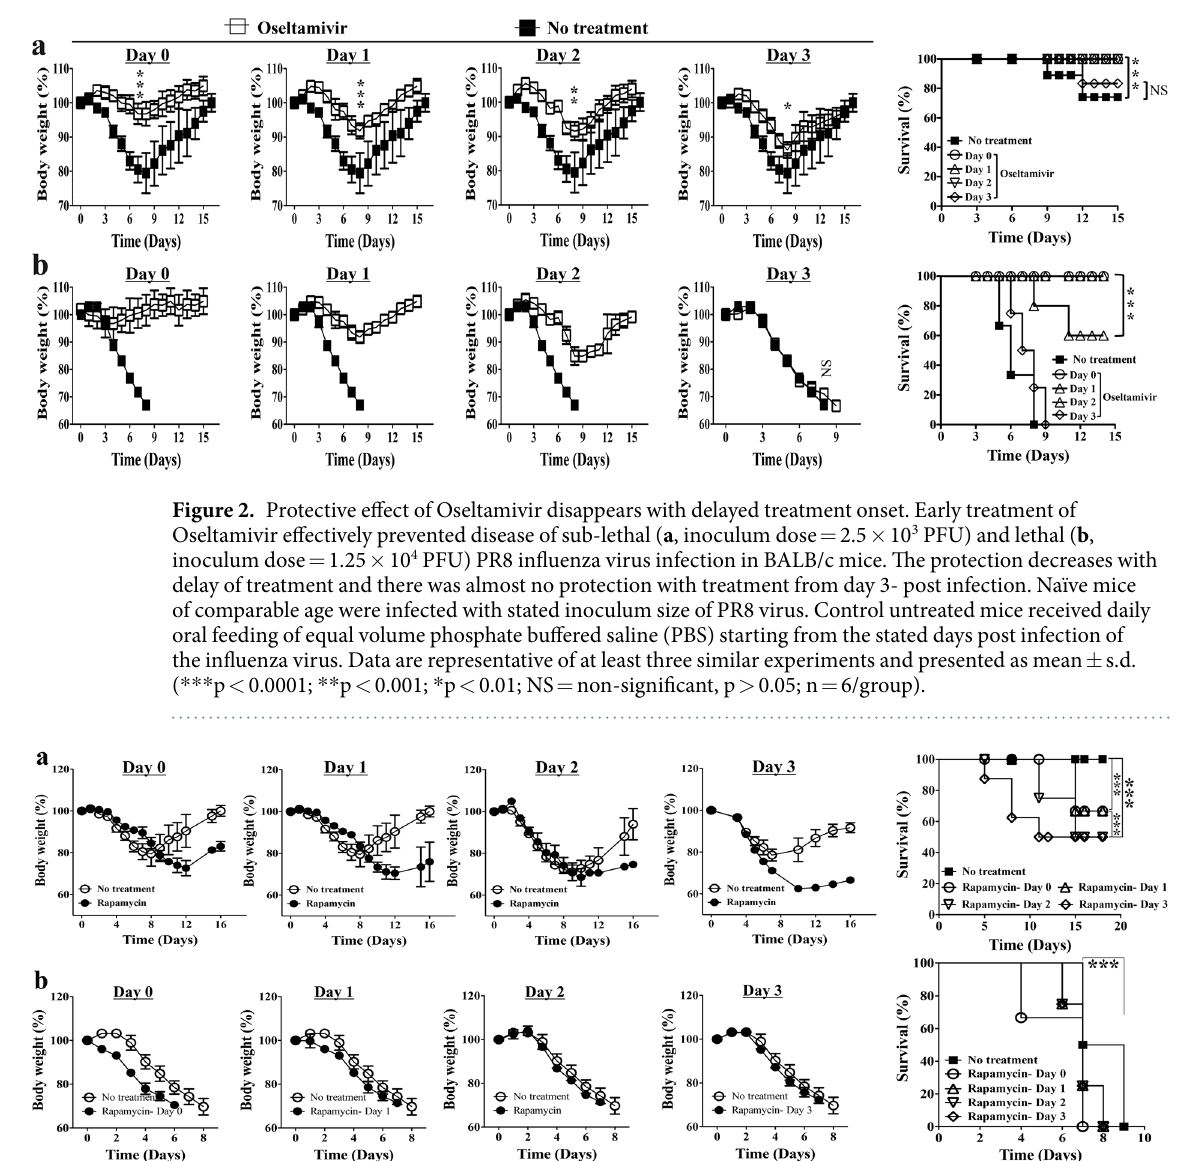
Rapamycin aggravates illness of both mild and severe disease regardless of timing of treat- ment. Rapamycin was given daily with intraperitoneal injection at the dose of 3 mg/kg of bodyweight. Immunosuppressive effects may hurt the mice in the early stage of infection during which effective immunity is desired for virus eradication. We started the timing of treatment starting from either day 0-, day 1-, day 2- or day 3- post infec- tion. Rapamycin caused more severe disease with either 2.5 × 10 3 or 1.25 × 10 4 PFU PR8 influenza virus infection, regardless of the timing of treatment. In infection with 2.5 × 10 3 PFU virus, the body weight loss was more profound in treated mice and some of them died but almost all the untreated mice recovered from illness (Fig. 3a). In infection with 1.25 × 10 4 PFU virus, both body weight loss and lethality were accelerated with Rapamycin treatment (Fig. 3b). Rapamycin does not salvage severe influenza progressive under Oseltamivir. Patients with sus- pected influenza may be prescribed Oseltamivir immediately upon presentation to medical attention. Even with this practice, the administration of Oseltamivir was delayed to at least a couple of days after they caught the